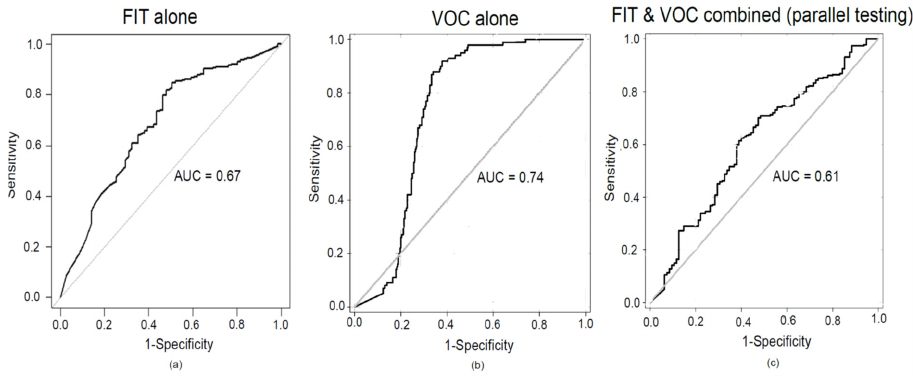
Figure 4. Receiver operator characteristics curve analysis for ( a ) FIT alone at 10 ug/g faeces, ( b ) VOC alone ( c ), FIT, and VOC in combination (when applied together) for the detection of a high-risk finding. FIT and VOC values were combined by neural networks through a complex mathematical vector method.